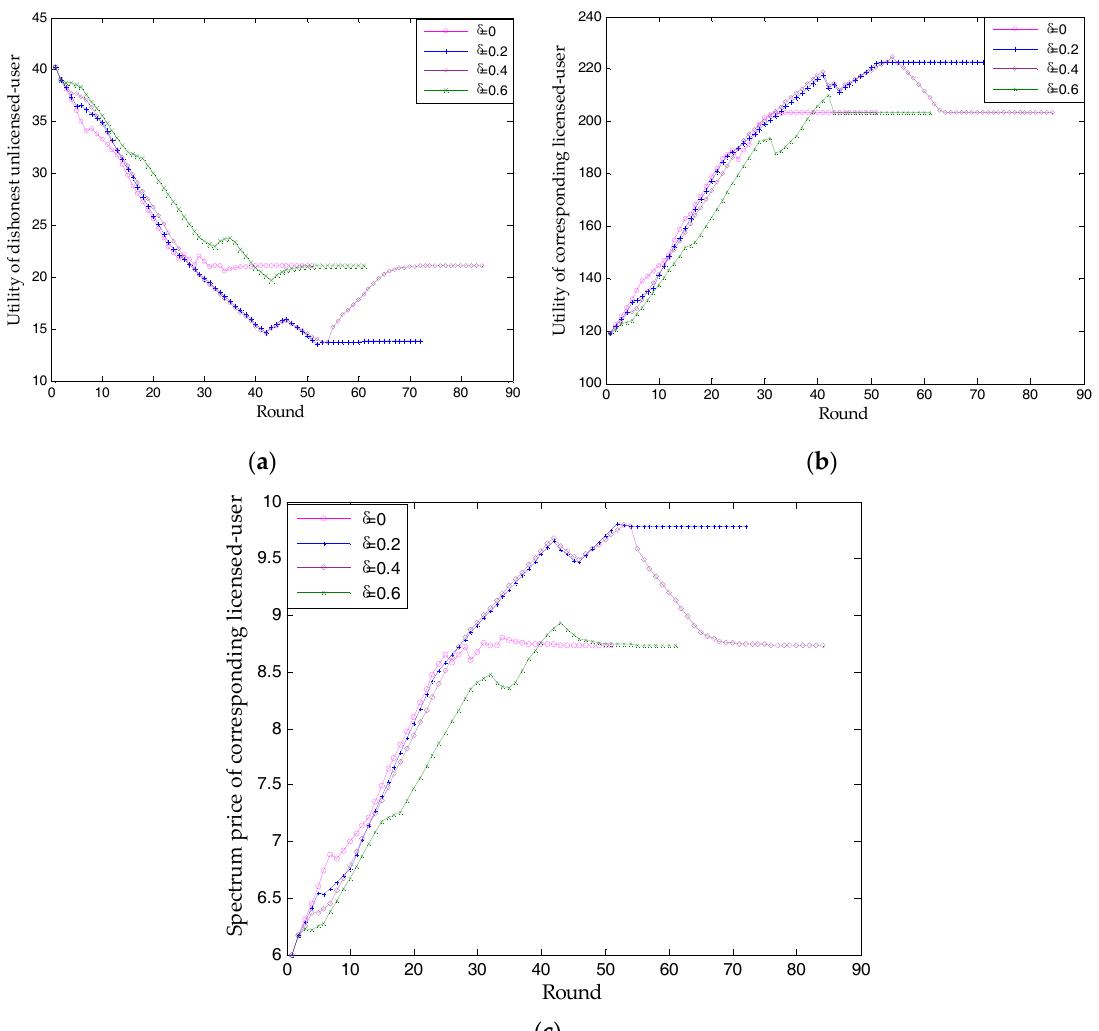
Figure 8. The influence of single unlicensed-user being dishonest: ( a ) utility of itself; ( b ) utility of corresponding licensed user; ( c ) spectrum price of corresponding licensed user.